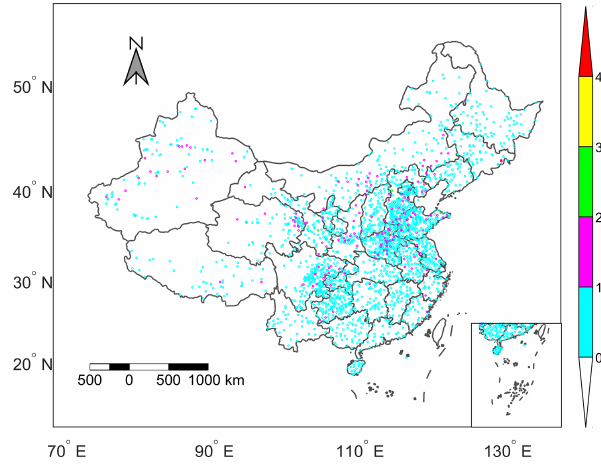
Figure 2. The number of in situ CASMOS sites within each 9km EASE grid across the study